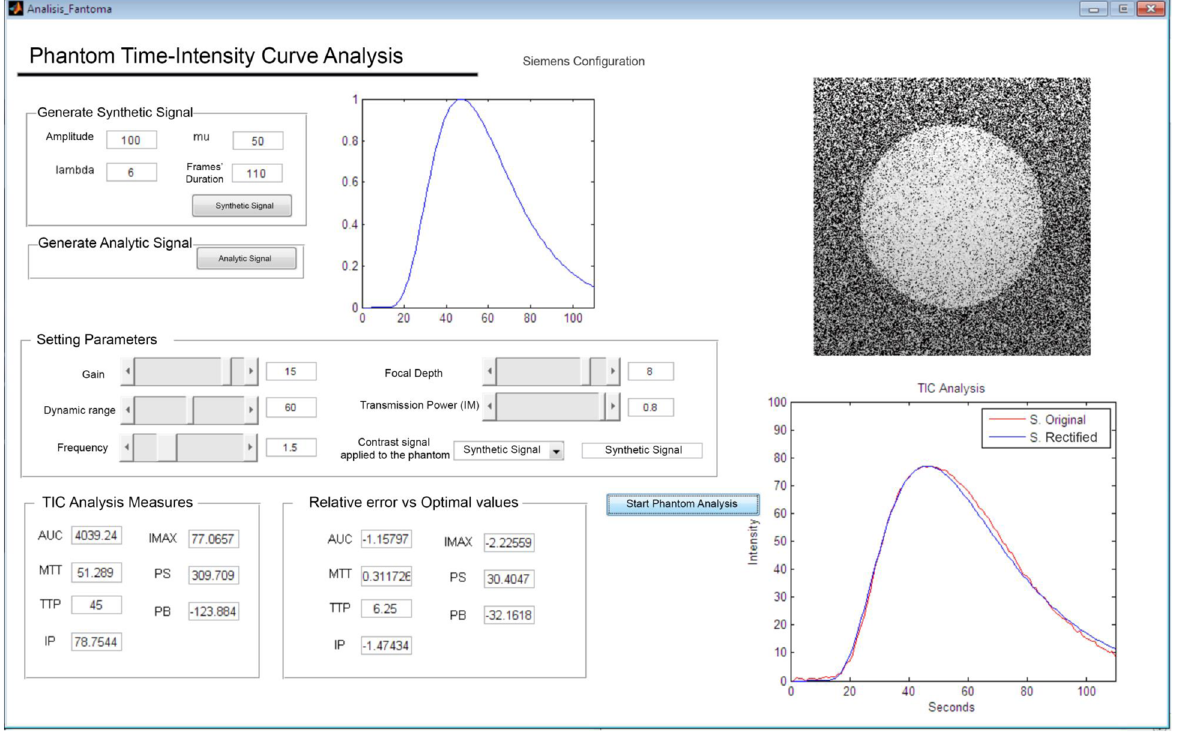
Fig. 2 User interface of the US perfusion digital reference object and signal